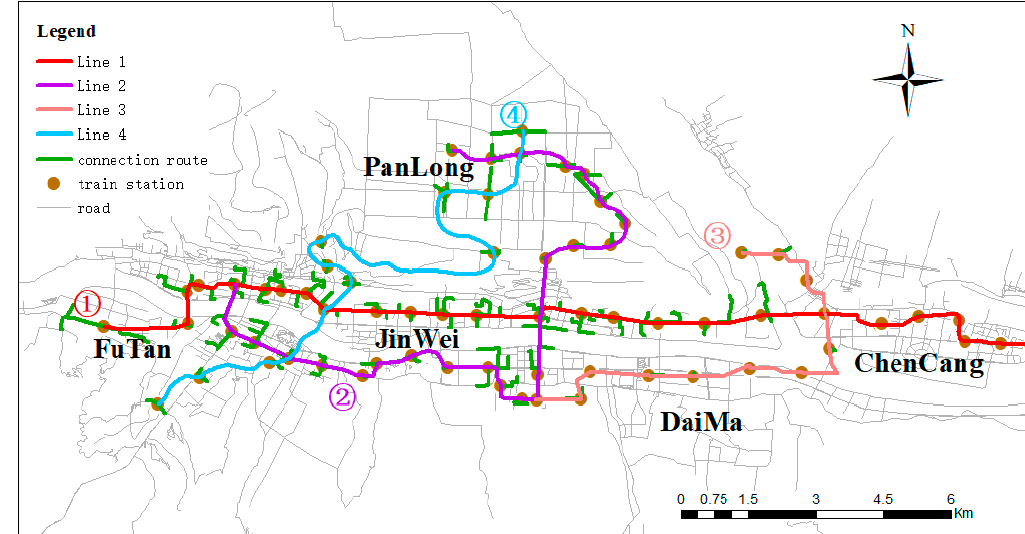
Figure 3. OD routes for individuals on road network of rail transit.